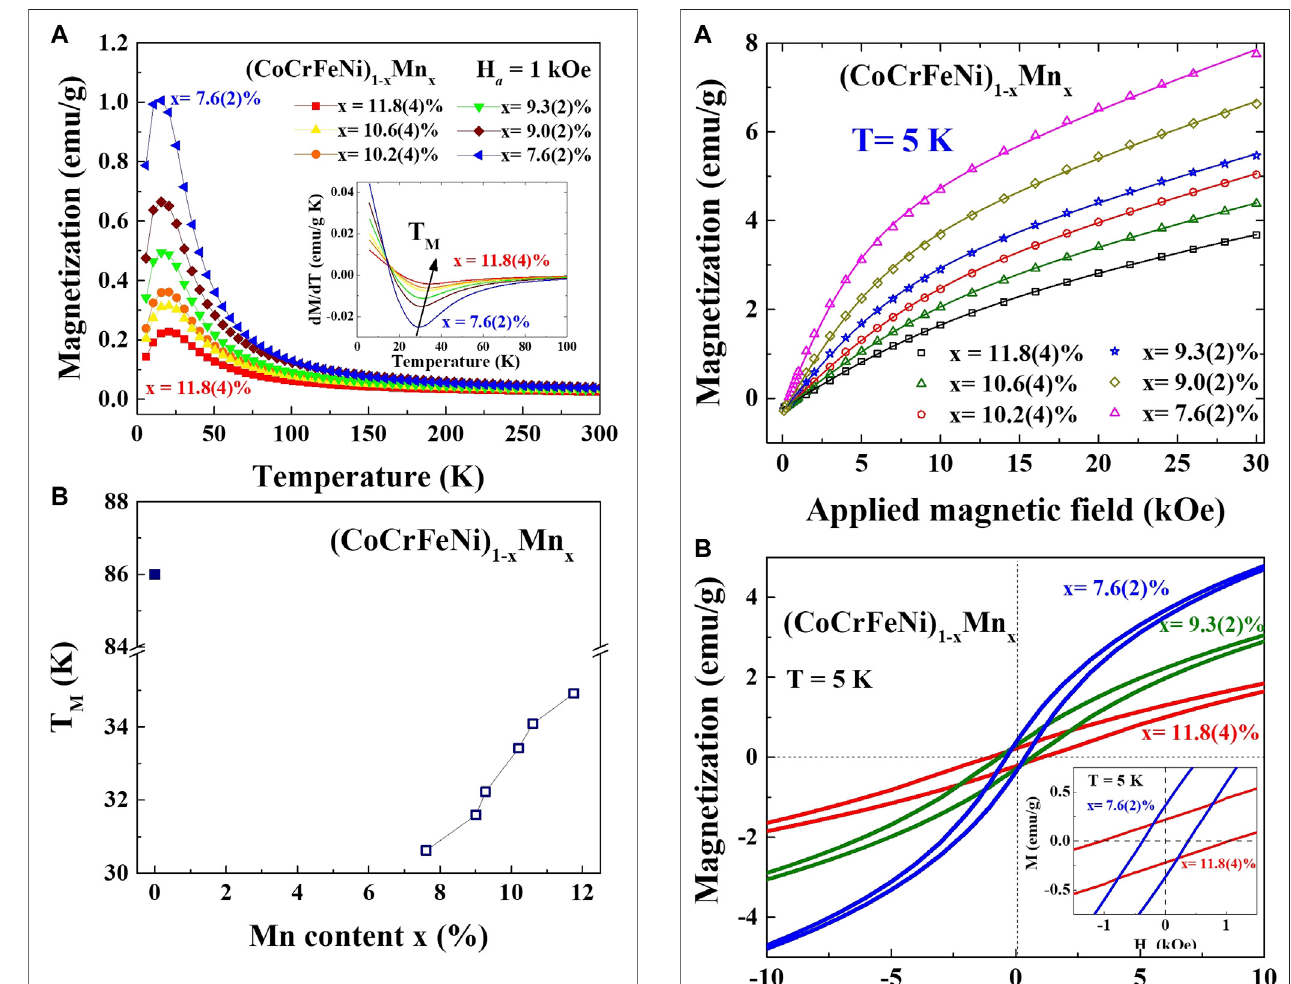
FIGURE4|(A) The M ( T ) curves ofthe(CoCrFeNi) 1 − x Mn x HEAs at x from 7.6 to 11.8% measured during warming with H a = 1 kOe. Inset to (A) , the transition temperature can be clearly determined from the derivative of magnetization with respect to temperature. (B) Variation of transition temperature with Mn content from x = 0 – 11.8%. FIGURE 5 | (A) The S2 ) by a Langevin function: